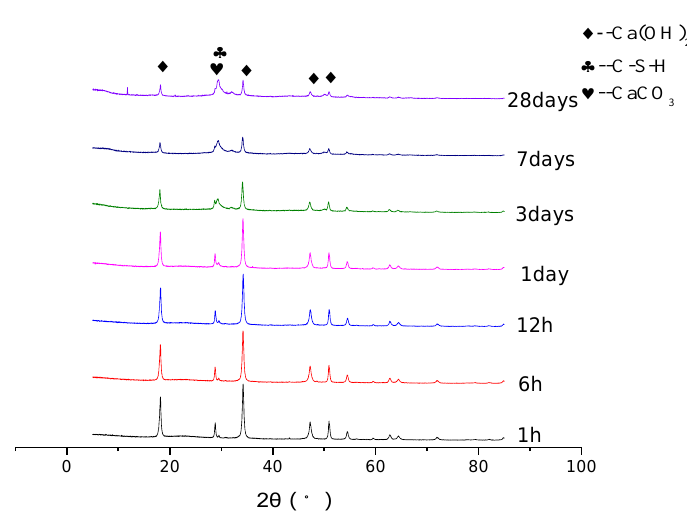
Figure 3. XRD patterns of the reaction of nano-SiO 2 with Ca(OH) 2 . Table 8. Peak intensity of Ca(OH) 2 .